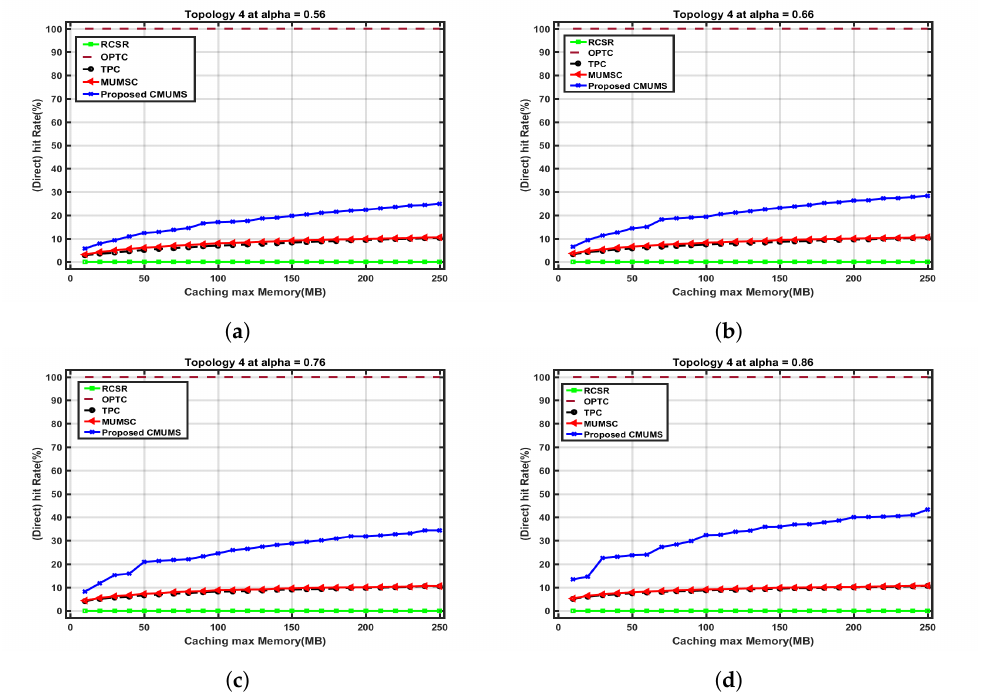
Figure 9. Direct hit rate vs. caching max Memory (Q) up to 250 MB at different α . ( a ) Direct hit rate vs. Q (at α = 0.56 as per [21]); ( b ) Direct hit rate vs. Q at α = 0.66; ( c ) Direct hit rate vs. Q at α = 0.76; ( d ) Direct hit rate vs. Q at α = 0.86.